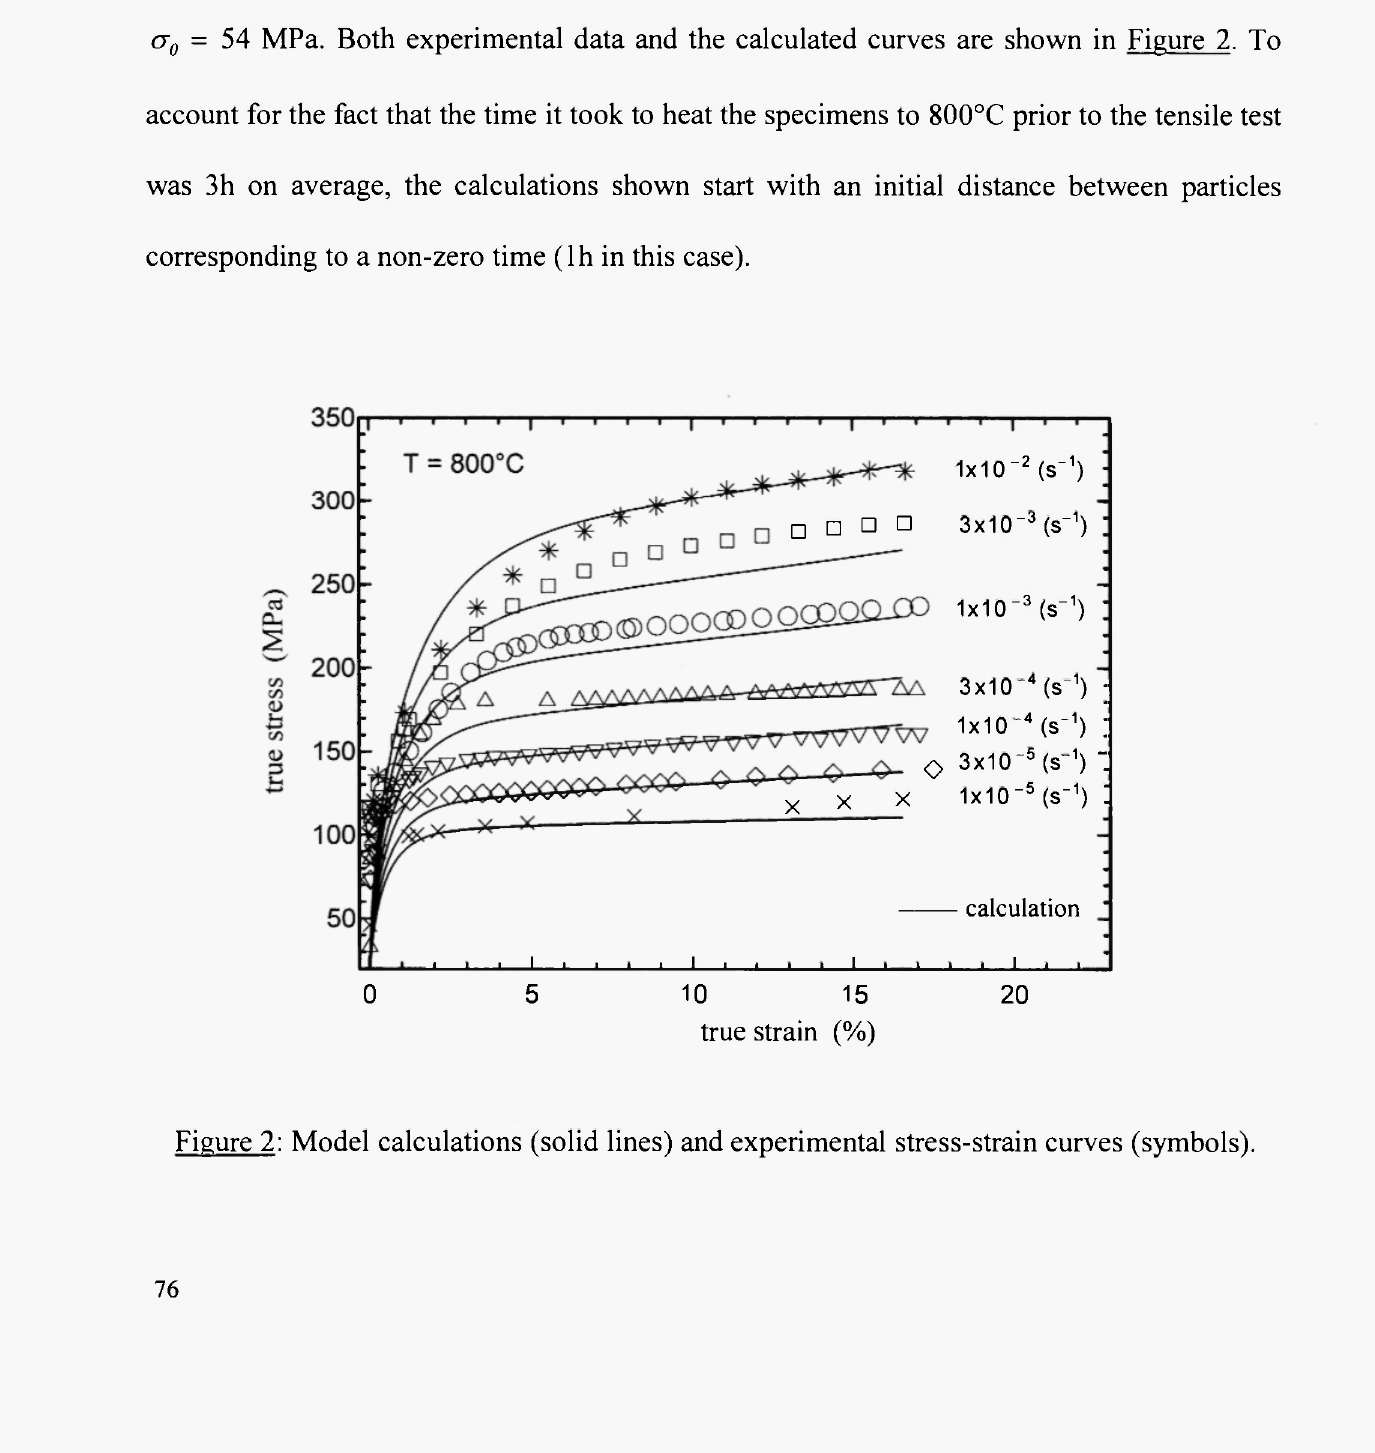
Figure 2: Model calculations (solid lines) and experimental stress-strain curves